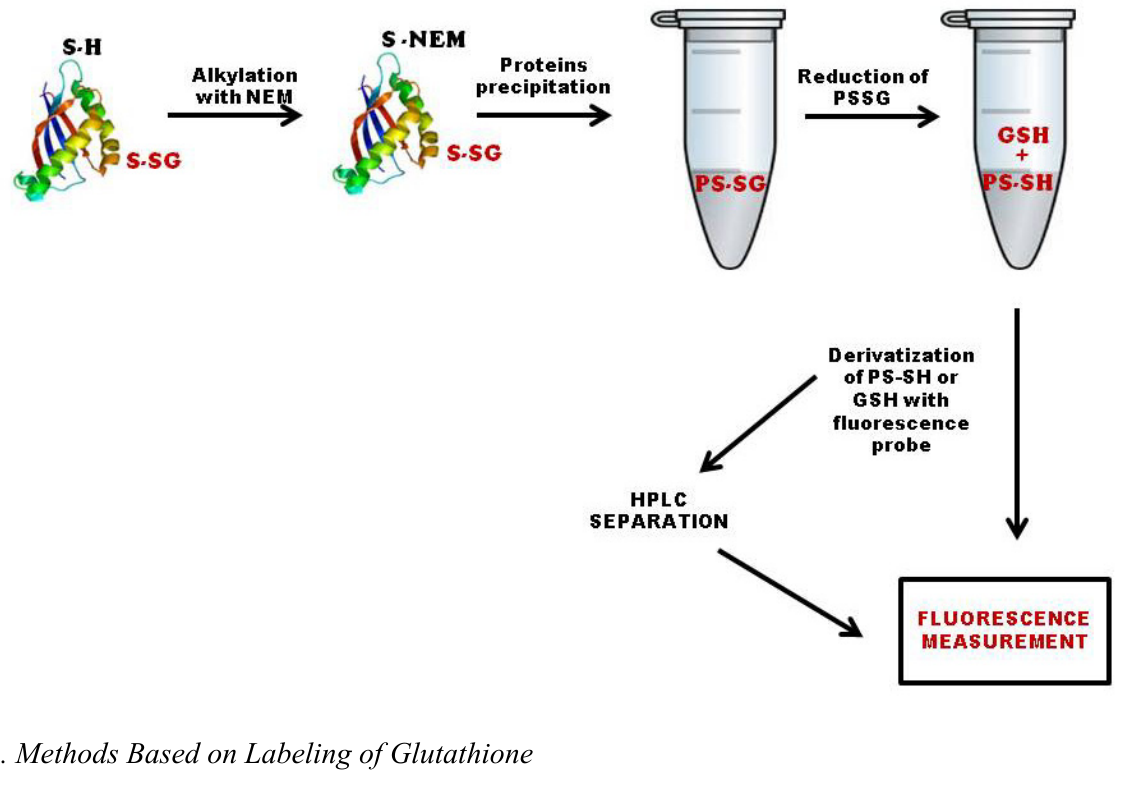
Figure 2. Quantification of total S -glutathionylated proteins. The first step of this method is the sample lysis or homogenization in non-reducing buffer containing N -ethylmaleimide (NEM) to eliminate free thiols. After this initial step, proteins were precipitated, resuspended and reduced. Protein-sulfhydryls or free glutathione formed after the reduction step was then derivatized with a fluorescence probe, and the fluorescence was measured by fluorometric analysis with or without prior HPLC